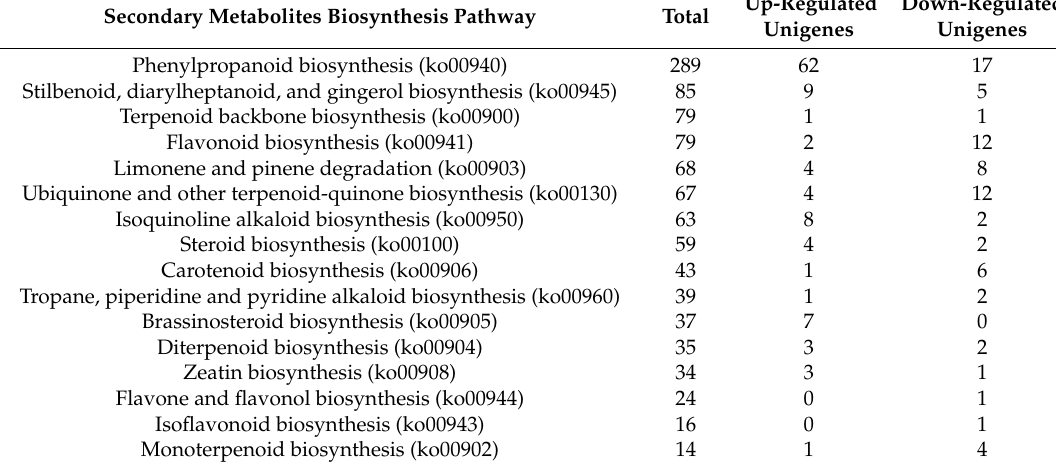
Numbers of unigene related to the secondary metabolism biosynthetic pathway in C. arachnoidea